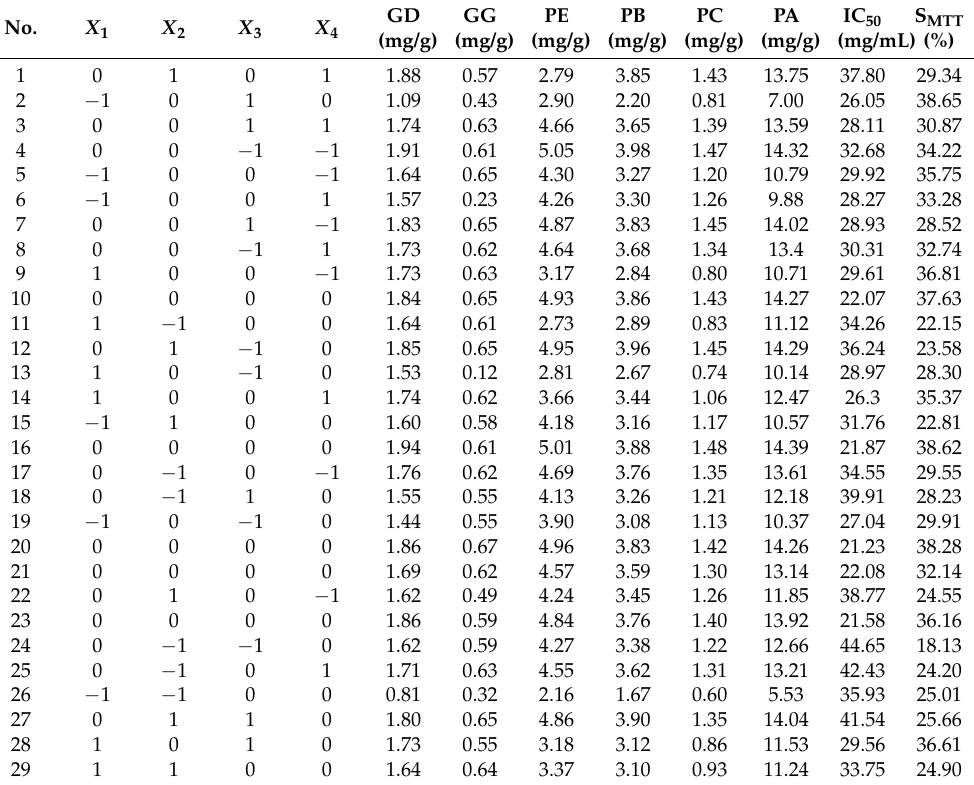
Table 3. The experimental design and results with four independent